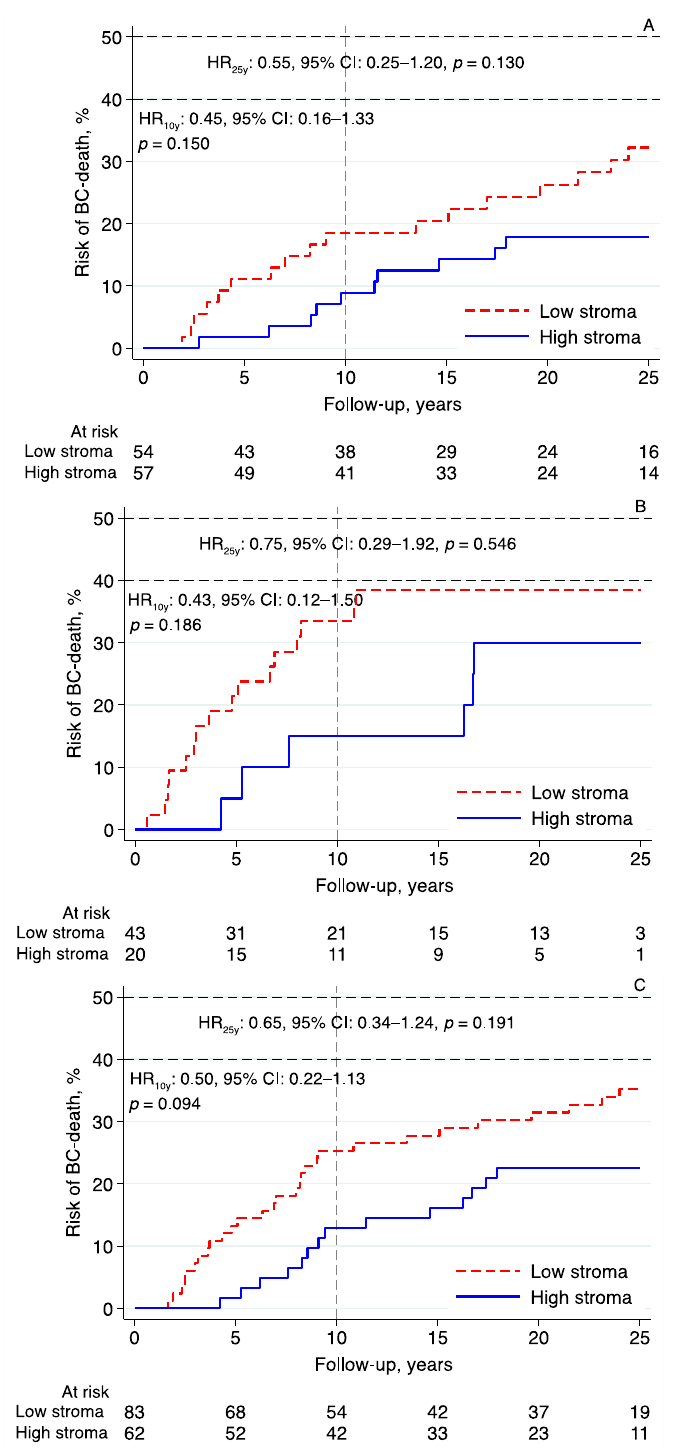
Figure 4. Risk of breast cancer death in lobular breast cancer by intratumoral stromal content; 10- and 25-year follow-up for ( A ) luminal A-like, ( B ) luminal B-like, and ( C ) NHG 2. Abbreviations: BC—breast cancer; CI—confidence interval; HR—hazard ratio; NHG—Nottingham histological grade; stroma; intratumoral stromal content.